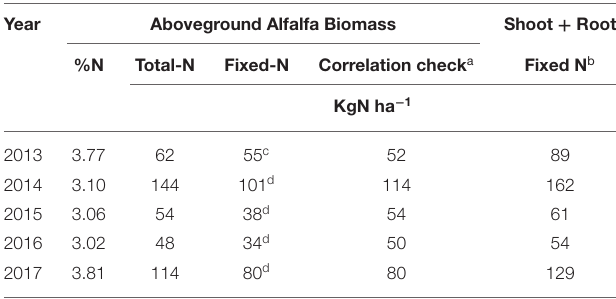
TABLE 2 | Shoot %N, total-N and fixed-N in alfalfa from the IWG-ALF treatment between 2013–2017 based on empirical and literature